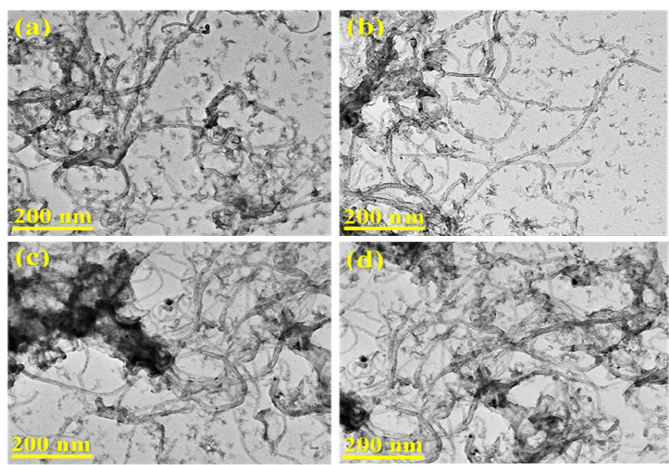
Figure 15. TEM images of the carbonous materials deposited over ( a ) Ni, ( b ) Ni-Co, ( c ) Ni-Fe, and ( d ) Ni-Cu catalysts.